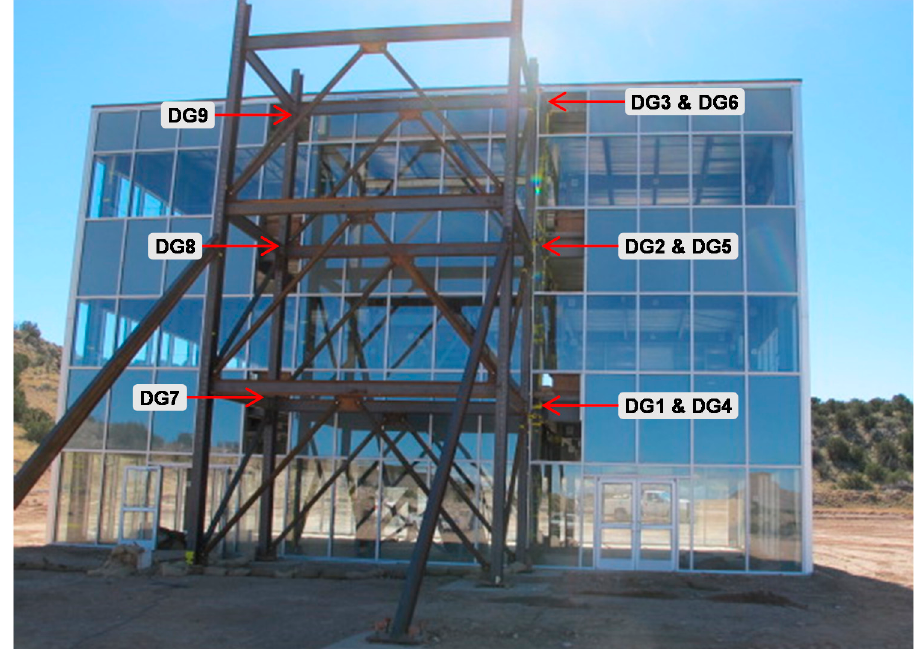
Figure 7. View of the instrumentation tower on the north (rear) elevation of the test structure indicating the locations of the displacement gauges (DG) at the three floor levels (same configuration on both tests).